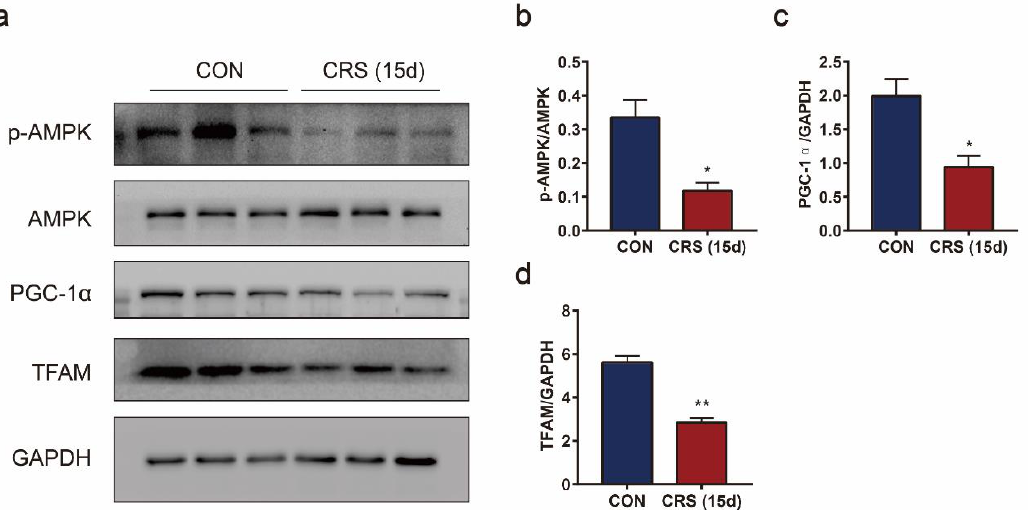
Figure 6. Effects of CRS on the AMPK/PGC-1α signaling pathway lead to muscle and mitochondrial dysfunction. Im- munoblotting of p-AMPK, AMPK, PGC-1α, and TFAM ( a ) in the gastrocnemius muscle, and the quantification of p- AMPK/AMPK ( b ), PGC-1α ( c ), and TFAM ( d ) protein abundance. Data are presented as the mean ± SEM (n = 3), * p < 0.05, ** p < 0.01.